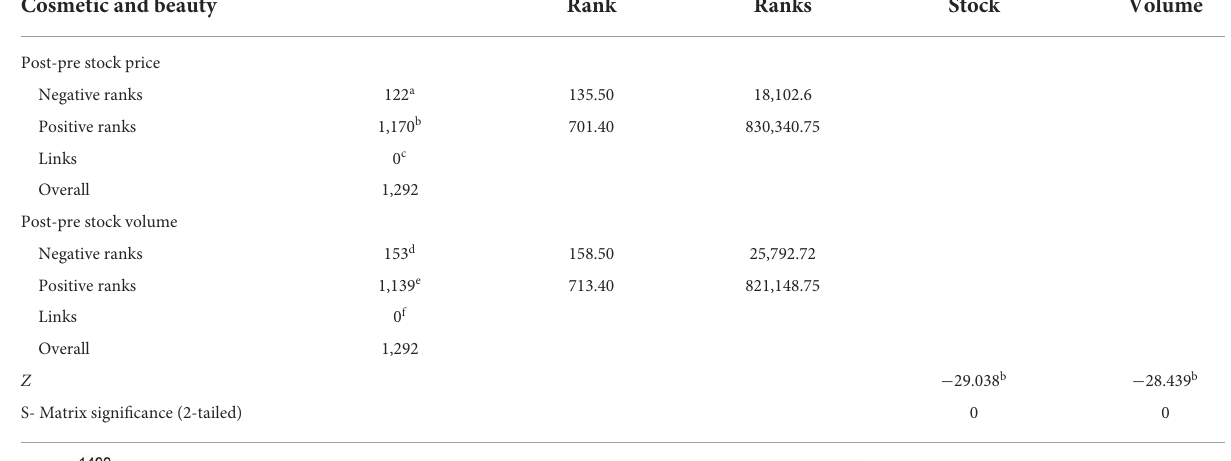
TABLE 5 Multiple regression of the cosmetic and beauty industry. Cosmetic and beauty